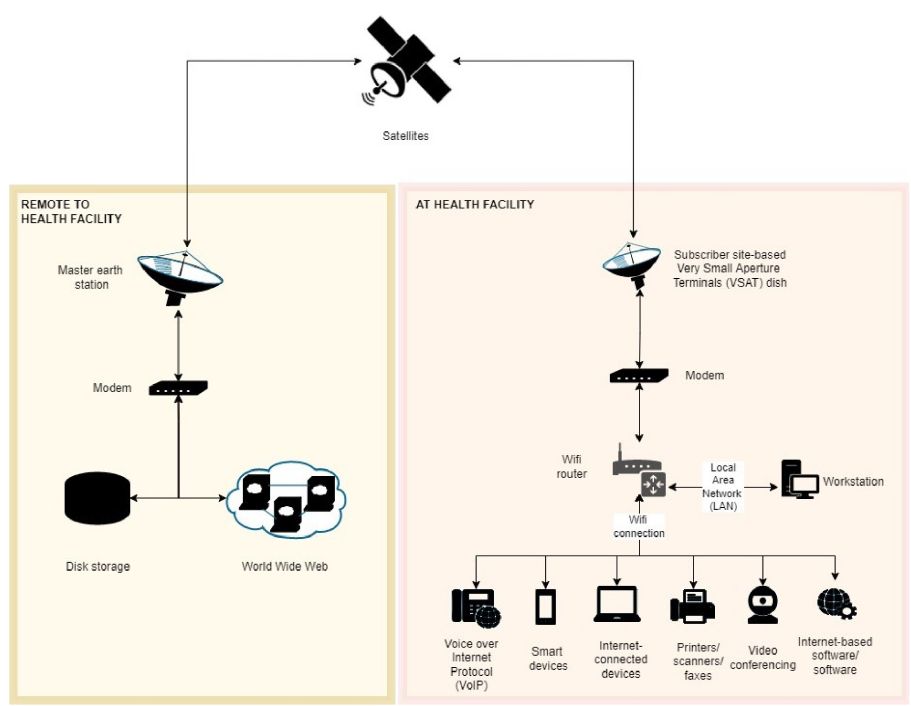
Fig 2. Schematic of the Tuvalu Very Small Aperture Terminal (VSAT) system. Caption: This figure is an author elaboration based on Fig 7 in [27]. Figure created with diagrams.net.